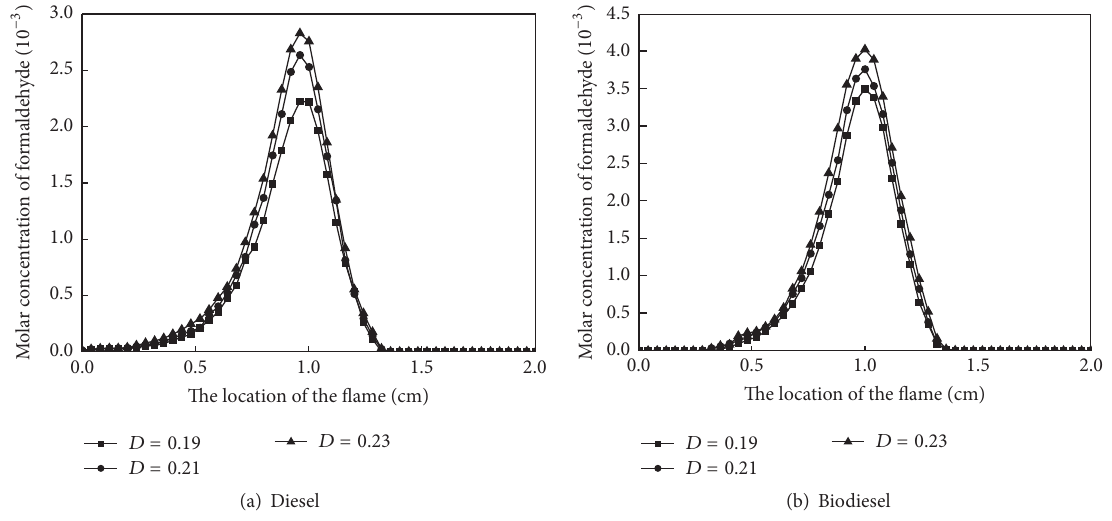
Figure 6: Influence of air dilution ratio on formaldehyde emission for diesel and biodiesel.